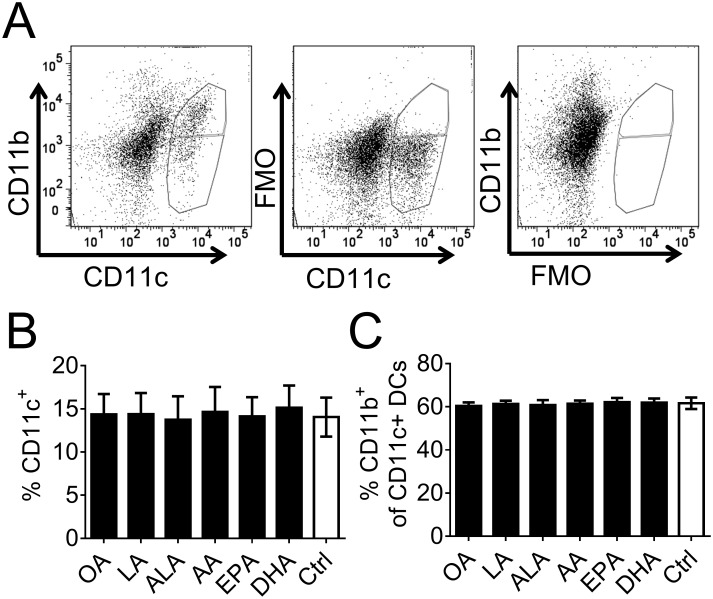
Distribution of dendritic cells (DCs) in fatty-acid supplemented cell cultures.DC cultures were supplemented with fatty acids (50 μM); α-linolenic acid (ALA), arachidonic acid (AA), eicosapentaenoic acid (EPA), docosahexaenoic acid (DHA), linoleic acid (LA) or oleic acid (OA) for 3 days and thereafter DCs were analyzed by flow cytometry. (A) Dot plots showing gating strategy for CD11c+ CD11bneg (lower gate) and CD11c+ CD11b+ (upper gate) DCs based on FMO (fluorescence minus one) samples. To the right a representative sample, in the middle FMO for CD11b and to the right FMO for CD11c. (B) Proportion of CD11c+ DCs, both CD11bneg and CD11b+, in fatty-acid supplemented cell cultures. (C) Proportion of CD11b+ cells within the CD11c+ population shown in Fig 2B. Black bars denote samples supplemented with fatty acid while white bar with black border denotes control (ethanol only). For each group n = 8. Error bars show standard deviation.